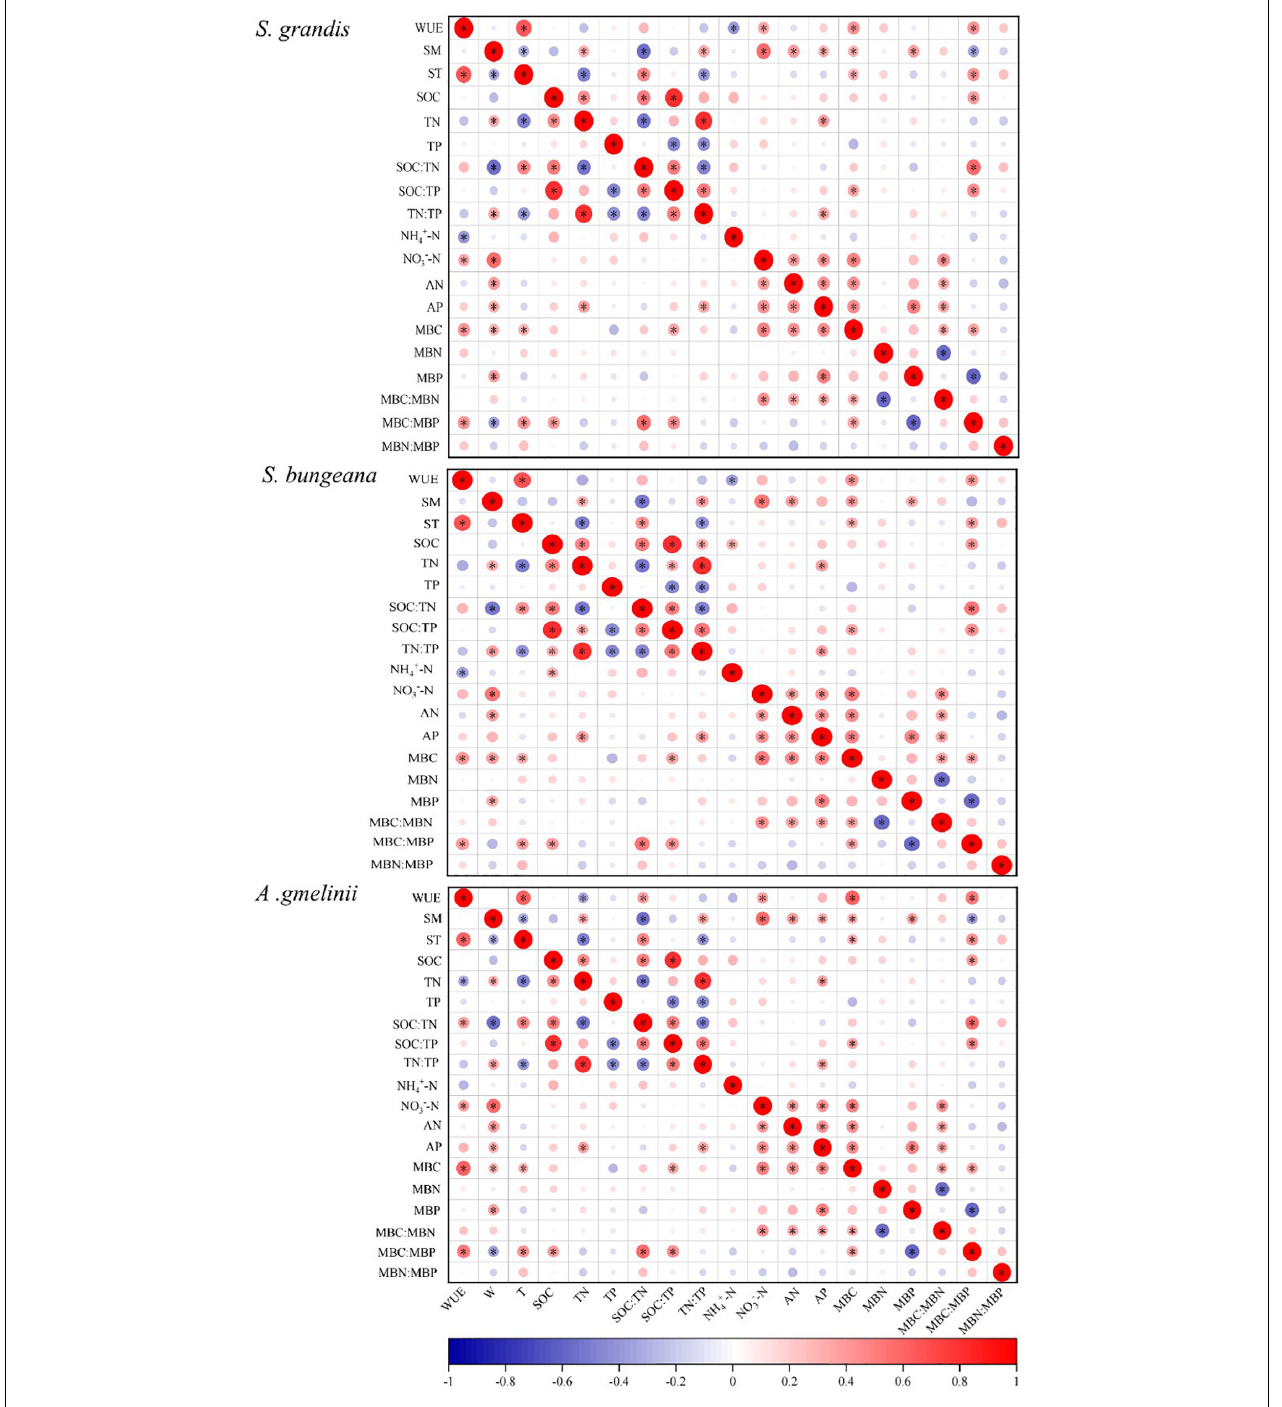
FIGURE 3 | Correlation analysis of factors affecting WUE with precipitation manipulation. CK, ambient precipitation; DP, decrease precipitation (–50%); IP, increase precipitation (+50%). WUE, water use efficiency; SM, soil moisture; ST, soil temperature; SOC, soil organic carbon; TN, soil total nitrogen; TP, soil total